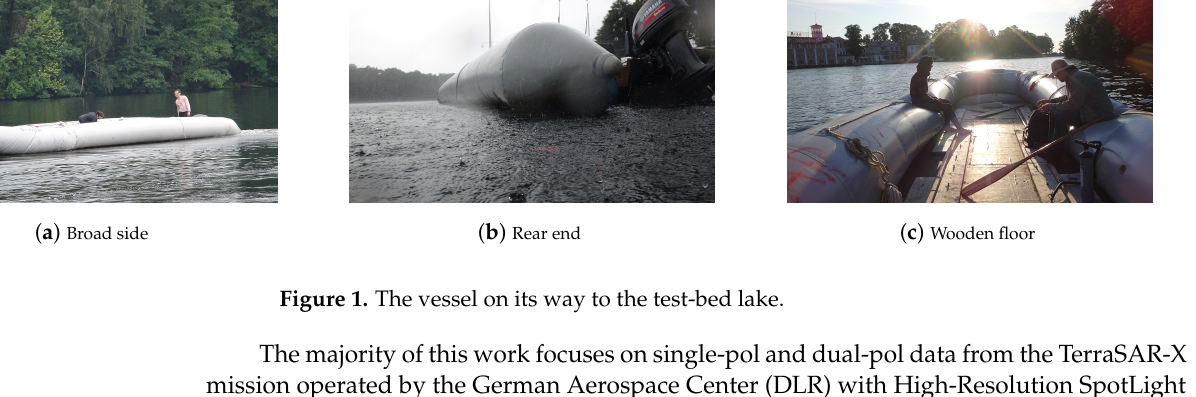
Table 1. Available data according to acquisition mode and polarization. Images from... TSX-HS